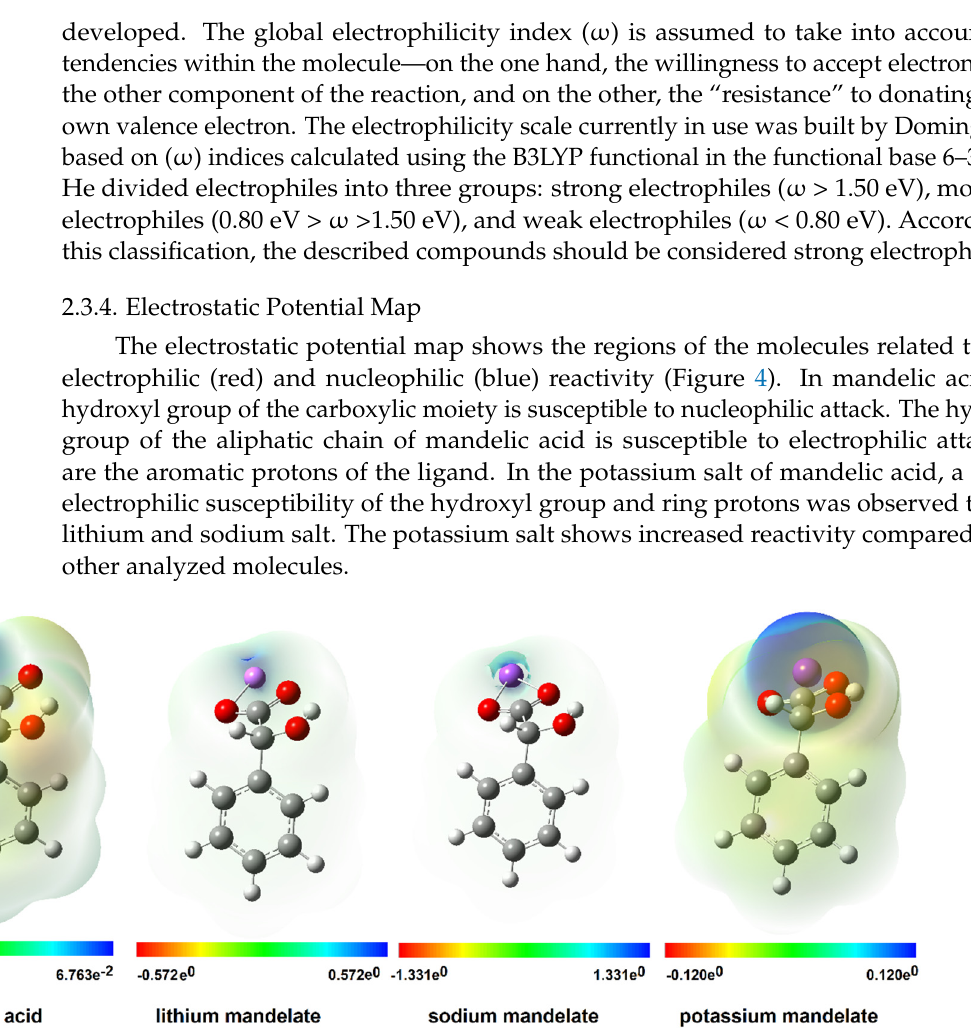
Figure 4. Electrostatic potential maps for mandelic acid and lithium, sodium, and potassium mandelate calculated in B3LYP/6-311++G(d,p).